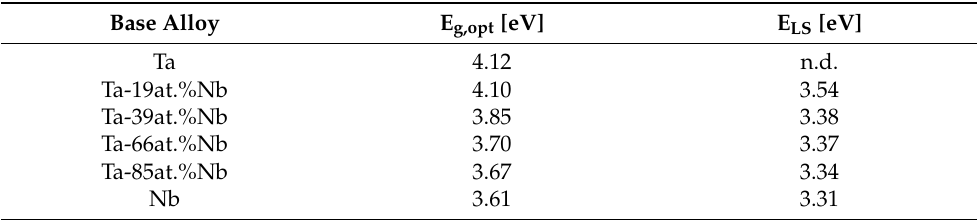
Figure 2. (Q ph · h ν ) 0.5 vs. h ν plots relating to photocurrent spectra, shown in Figure 1, for anodic films grown up to 50 V vs. cathode in ABS on ( a ) Ta, ( b ) Ta-19at% Nb, ( c ) Ta-39at% Nb, ( d ) Ta-66at% Nb, ( e ) Ta-85at% Nb and ( f ) Nb. E g,opt values, estimated according to Equation (3), are reported in Table 2. Table 2. Band gap and second optical absorption threshold values estimated according to Equation (3) relating to all the anodic oxides.